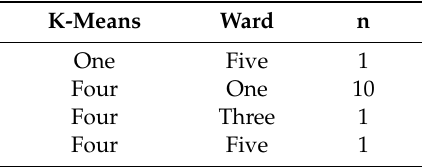
Table 2. Misclassifications.